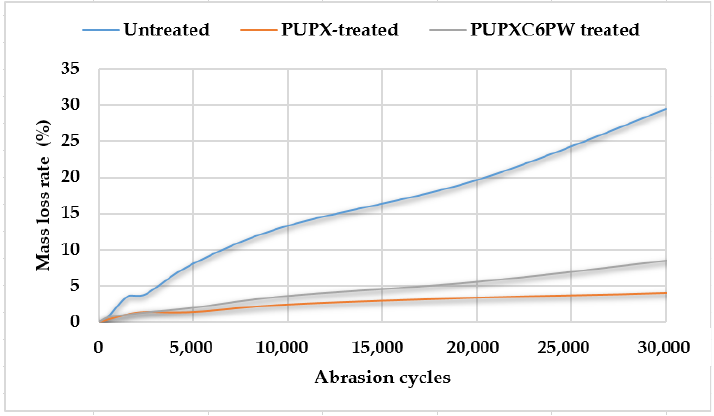
Figure 9. Mass loss rate variation during abrasion cycles before any washes.